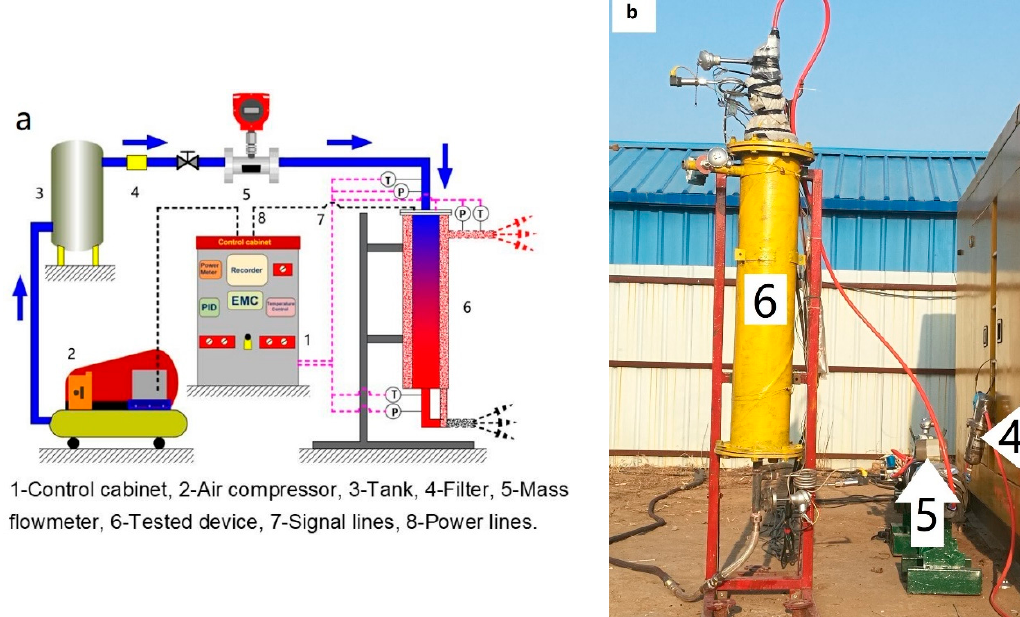
Figure 4. ( a ) Schematic diagram and ( b ) photograph of experimental system.